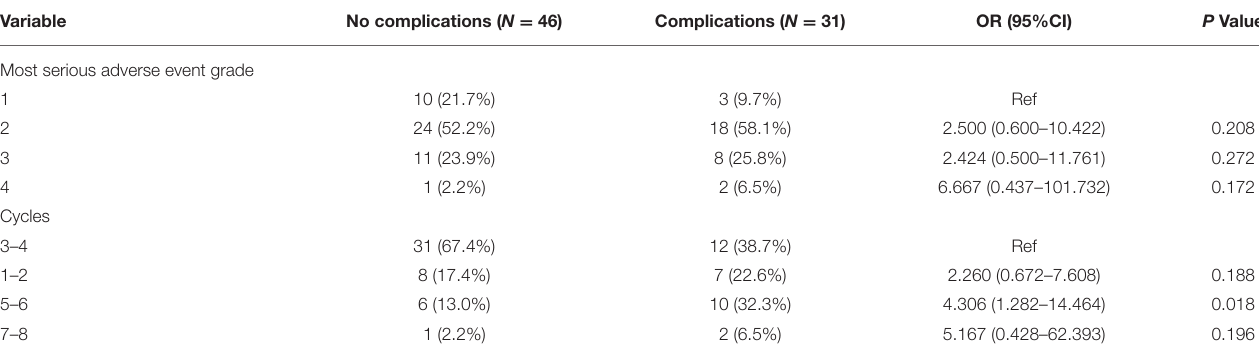
TABLE 3 | Association between complications and preoperative adverse events. Variable No complications ( N =